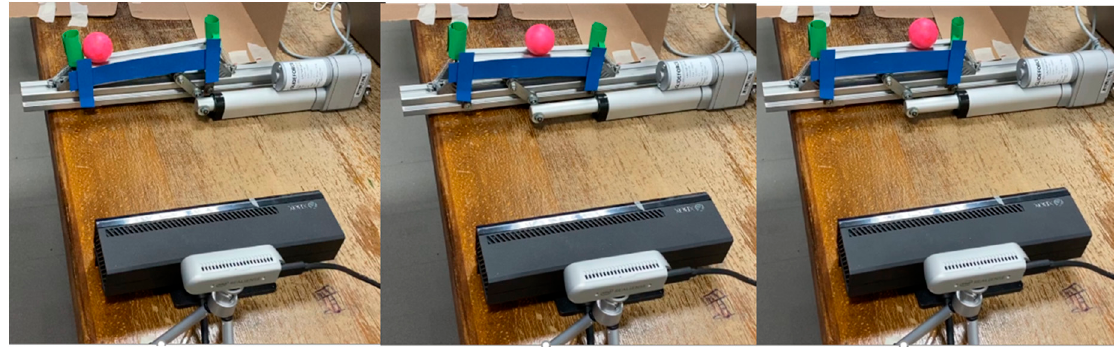
Figure 13. Three consecutive frames of the ball equilibrium application (Left, Middle, Right). The error in control action represents the current ball distance from the starting zero point. As it is possible to see in Figure 14, the ball wobbled before reaching an equilibrium position at around 11 mm from the zero point. This is the control result for a time gain of 0.09 for the derivative calculation.